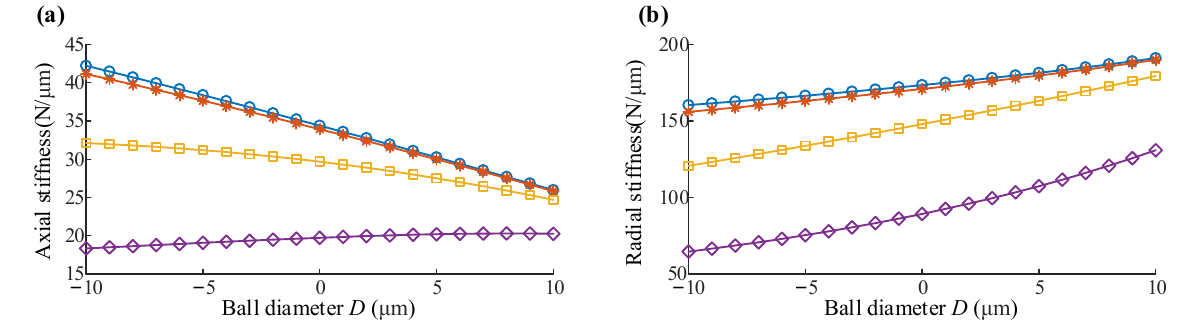
Figure 15. The influences of ball diameter on bearing stiffness: ( a ) bearing axial stiffness varies with ball diameter D ; ( b ) bearing radial stiffness varies with ball diameter D ( — ○ — rotating speed = 0 rpm, — ∗ — rotating speed = 5000 rpm, — □ — rotating speed =10,000 rpm, — ◇ — rotating speed = 20,000 rpm).